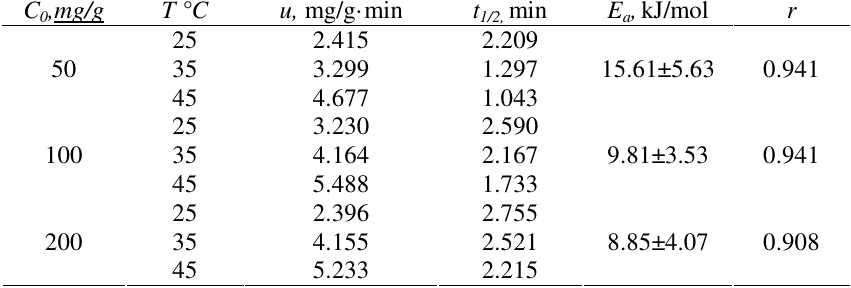
Table 8. Kinetic parameters for the second-order adsorption model of PVA (700) C , 0